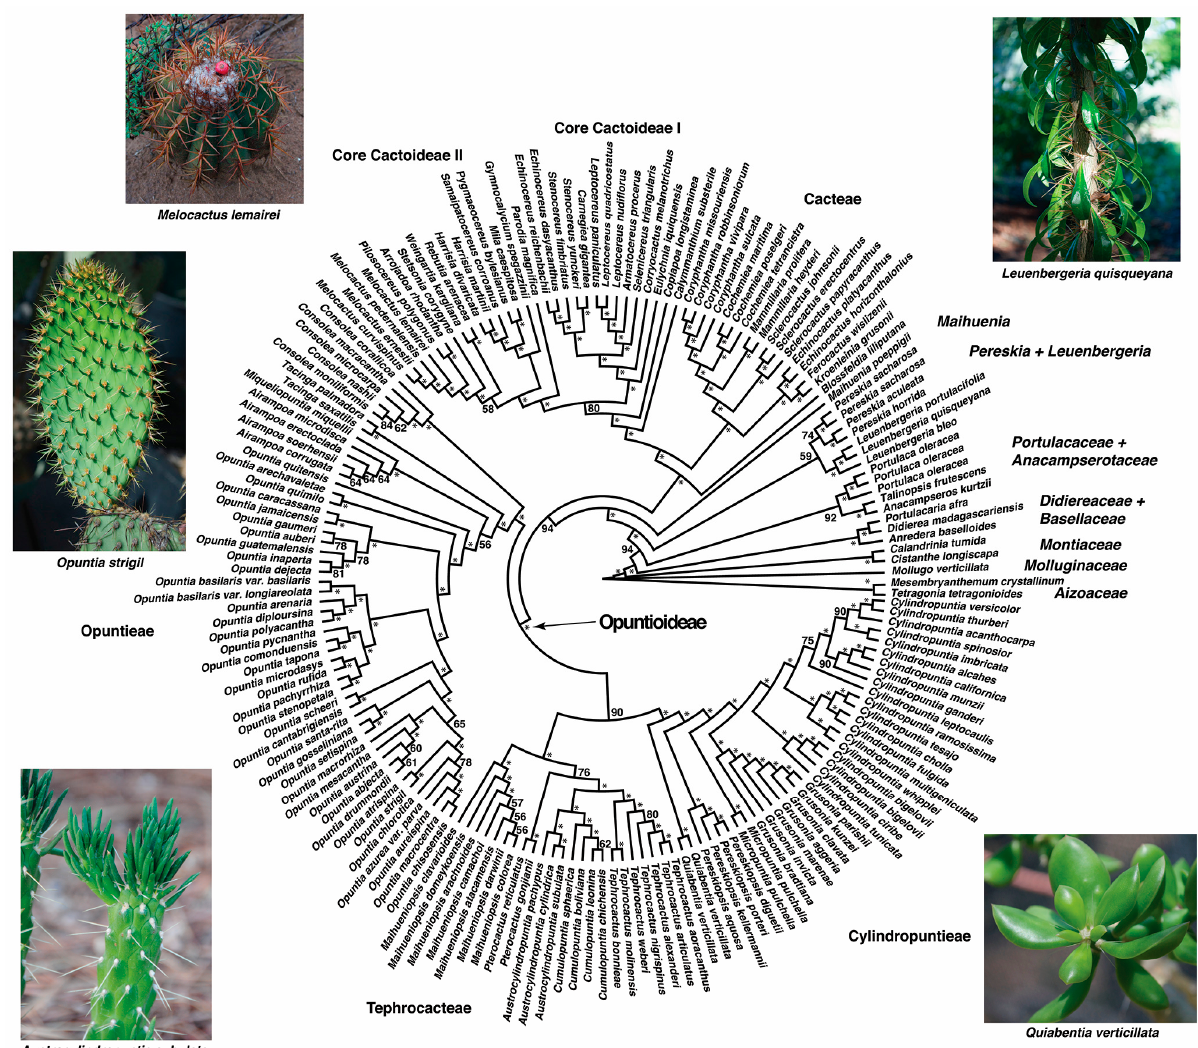
Figure 1. Maximum likelihood topology from RAxML. Cactaceae were recovered as sister to an Anacampserotaceae + Portulacaceae clade. Pereskia and Leuenbergeria were poorly supported as a clade, and Maihuenia was supported as sister to a Cactoideae + Opuntioideae clade. Opuntioideae was well supported and consisted of an Opuntieae + (Cylindropuntieae + Tephrocacteae) clade. Bootstrap support (bs) is given above branches. * = 100 bs, and support <100 is given. Photos taken by L.C.